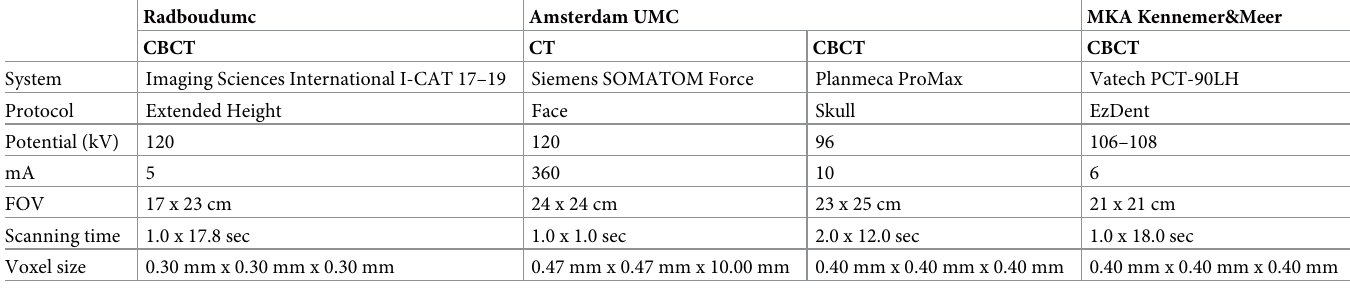
Table 1. Scanning details per center.